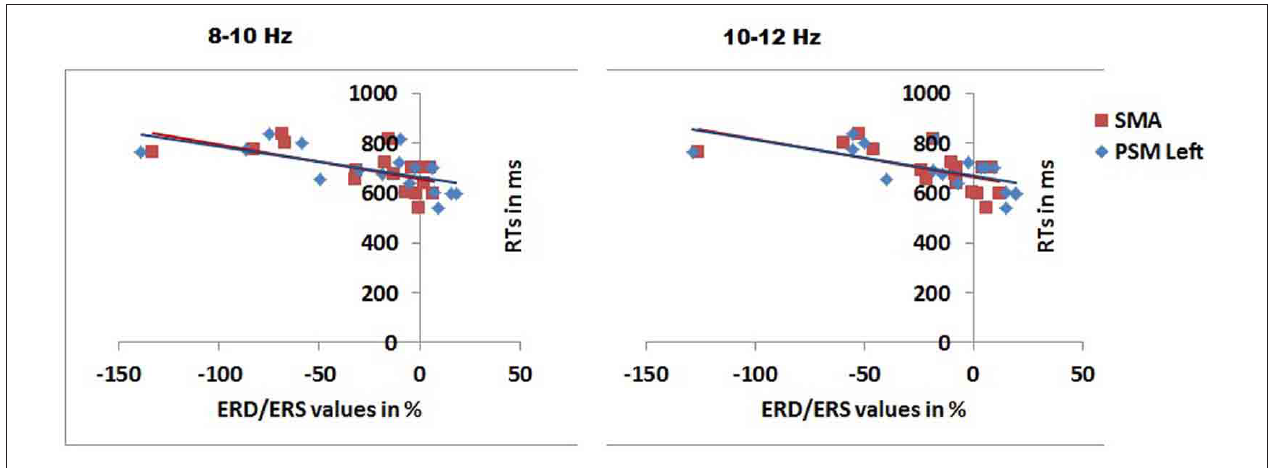
FIGURE 6 | Scatter plots with the best fitting linear lines showing significant correlations between RTs for congruently gripped objects and mu rhythm ERD/ERS over different scalp regions in 8–10 and motor